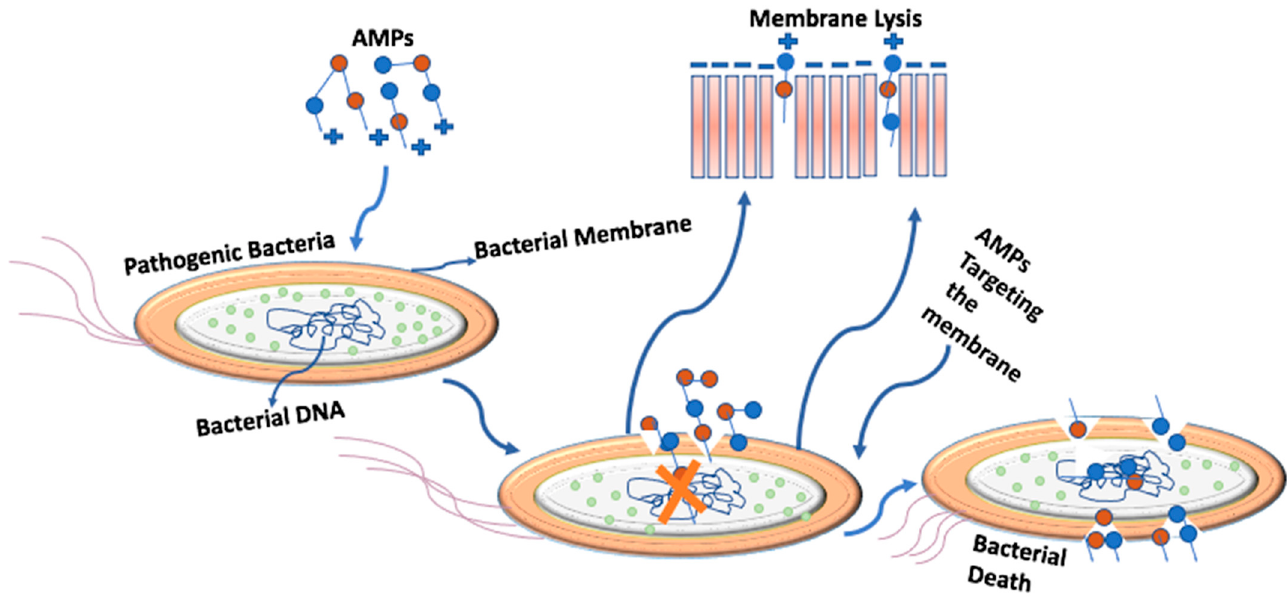
Figure 2. Shows the electrostatic interaction of membranes. Cationic AMPs target the anionic bacte- rial membrane. AMPs penetrate into the cell membrane and cause cell death. membrane. AMPs penetrate into the cell membrane and cause cell